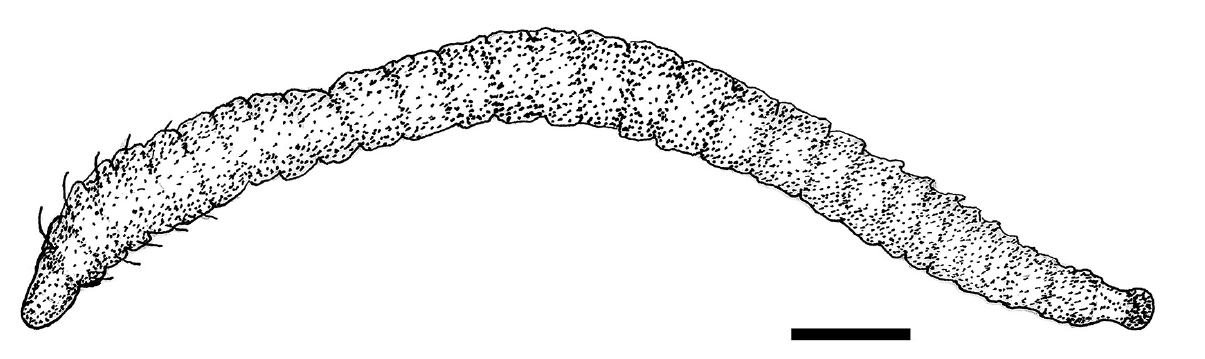
Fig. 1. – Immature female of Capitella sp. in lateral view (scale bar: 1